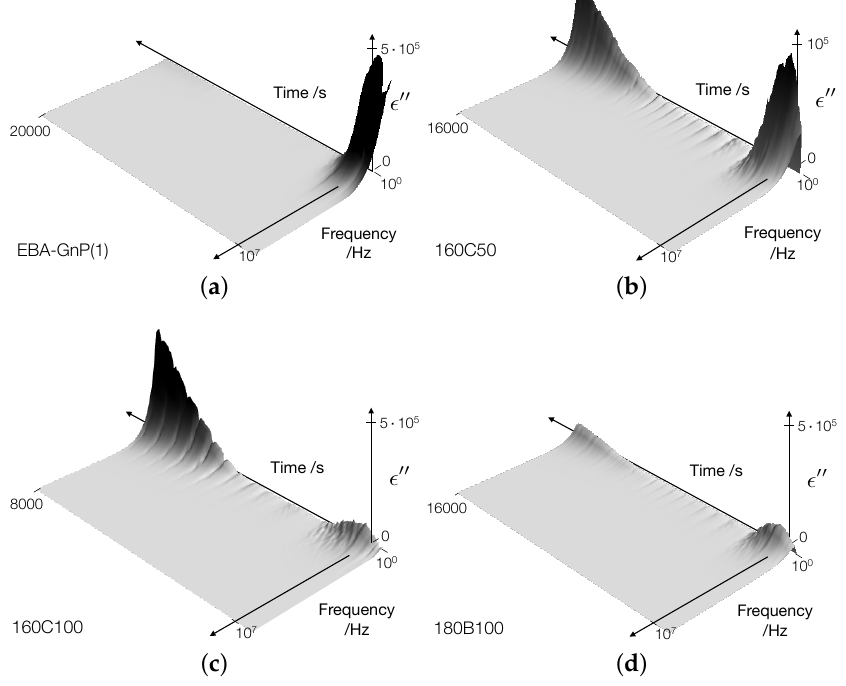
Figure 10. Transient development of the dielectric loss, (cid:15) (cid:48)(cid:48) , spectra for: ( a ) EBA-GnP, ( b ) 160C50, ( c ) 180C50 and ( d )